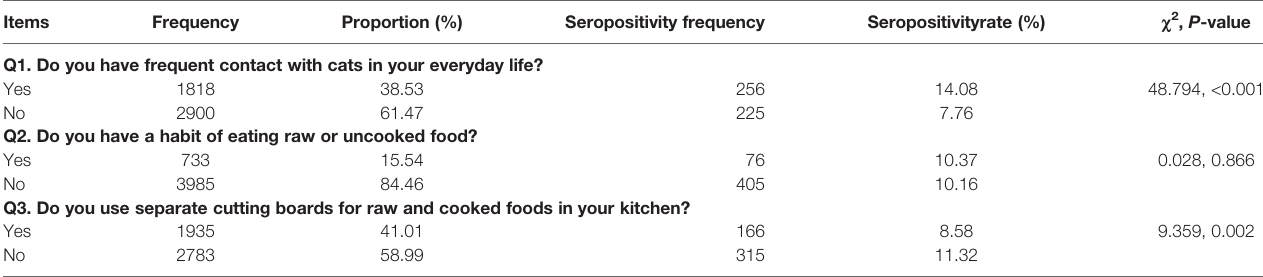
TABLE 5 | Practices for prevention of and seropositivity rates of toxoplasmosis in the 4 population categories.